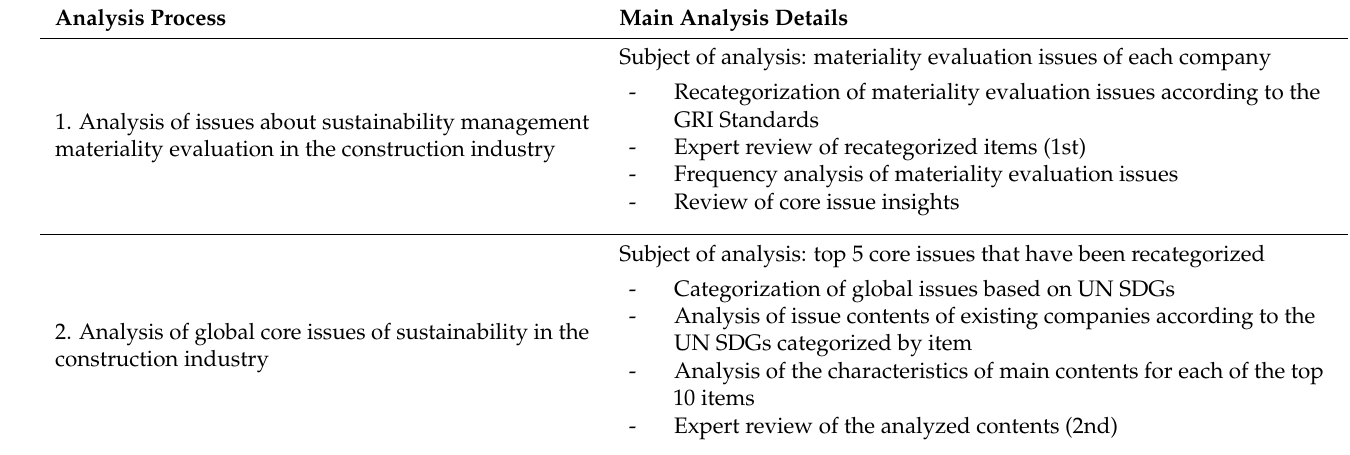
Table 5. Issue analysis framework for sustainability materiality evaluation of the construction